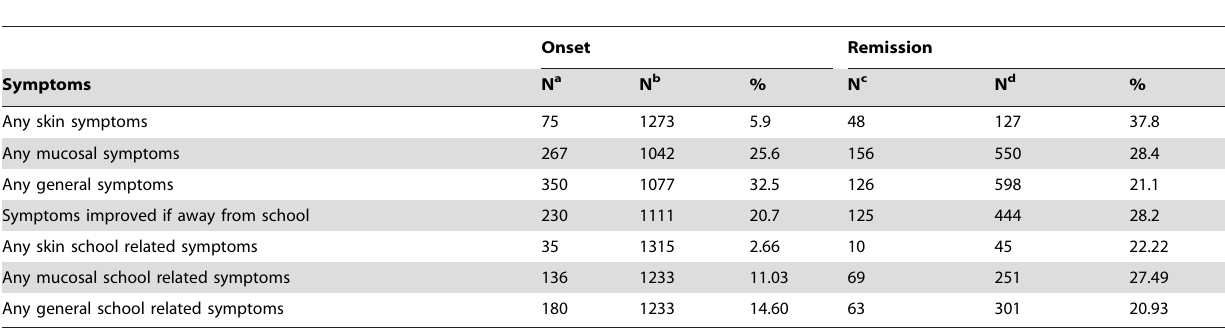
Table 3. The number of cases and percentage of new onset and remission of SBS symptoms during the two-year follow-up (N=